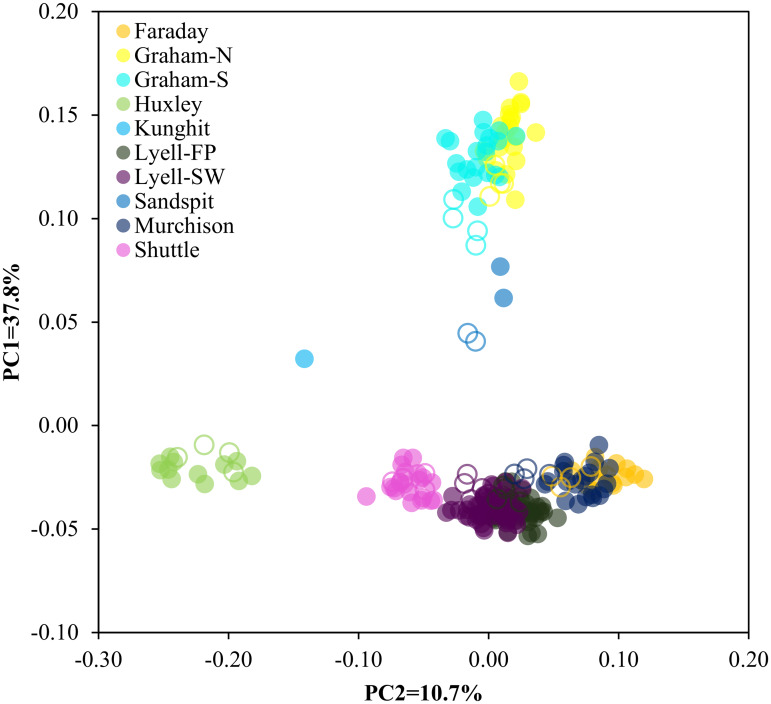
Principle component analysis (PCA) for black rats (Rattus rattus, n = 249) collected throughout Haida Gwaii, BC.Eigenvectors were inferred using ddRAD samples (filled circles; n = 214), with GT-seq samples (hollow circles; n = 35) posteriorly projected onto inferred eigenvectors. All analyses were performed using the same 429 loci, and implemented using EIGENSOFT v7.2.1 [49–51].